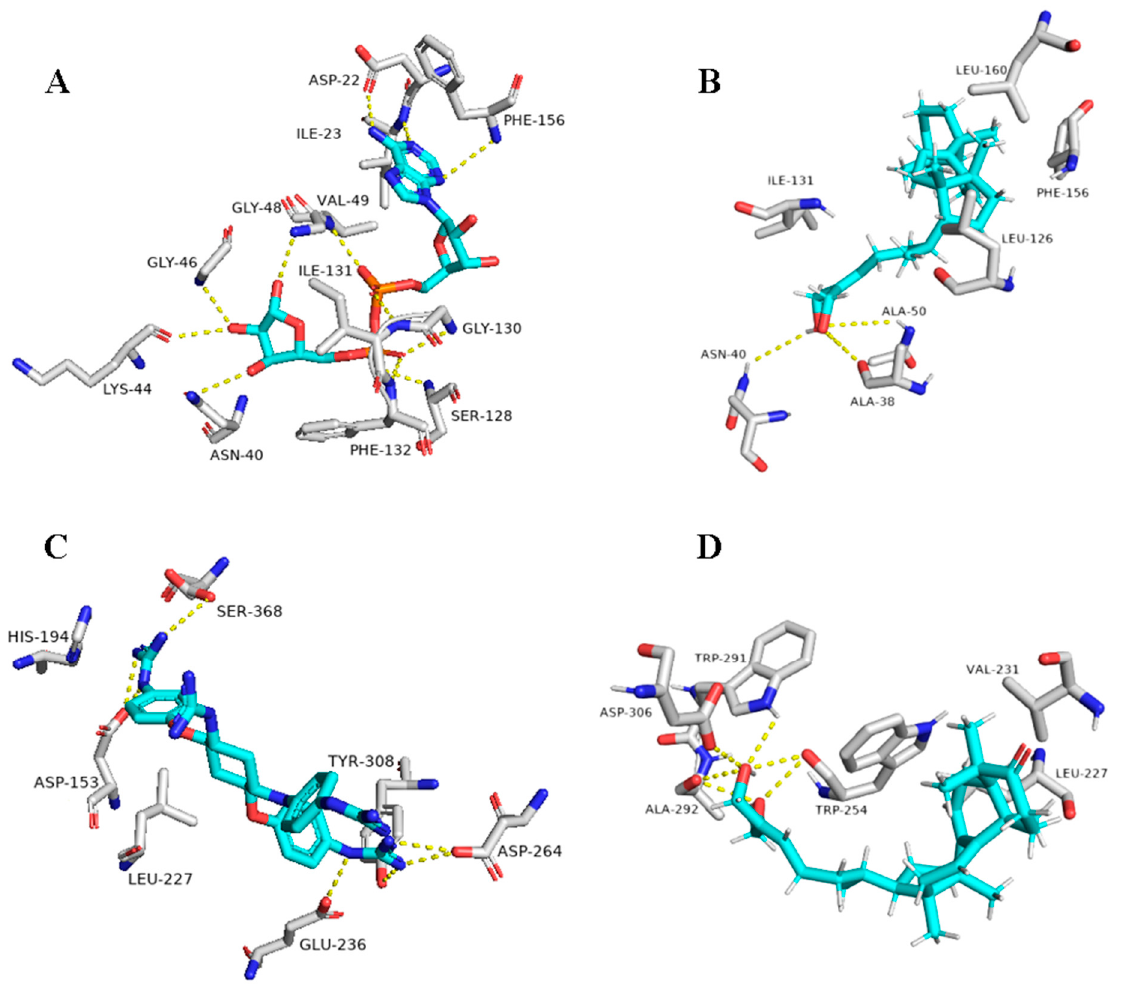
Figure 10. Binding modes of Ganoderiol F (14) inside the viral and human-based targets. ( B , D ) Interactions inside both ARP and furin, respectively. ( A , C ) co-crystallized ligands of ARP and furin, respectively.